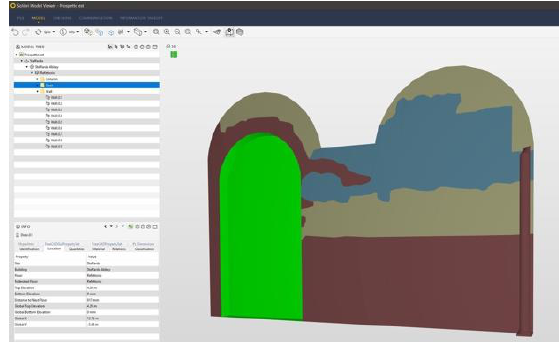
Figure 6. IFC model inside Solibri Model